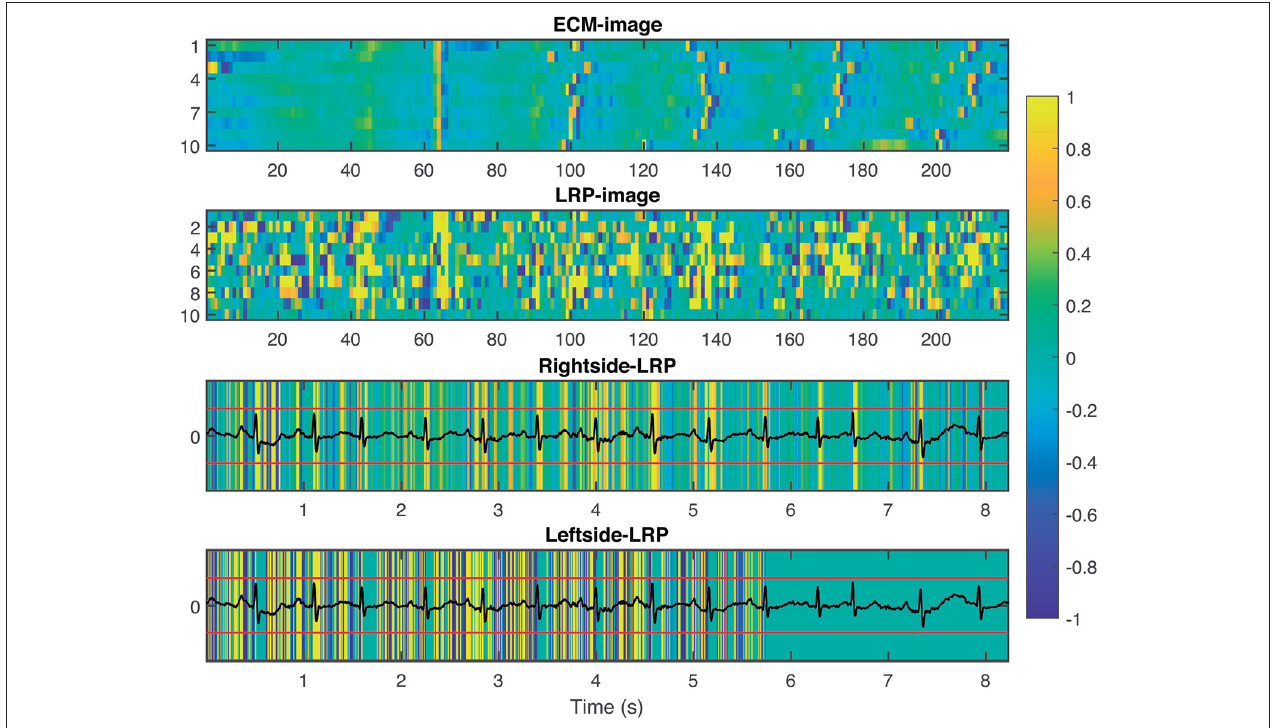
FIGURE 5 | From top to bottom : ECM-image labeled as non-AF and correctly classified as non-AF, heatmap image resulting from the LRP process, rightside-LRP, and leftside-LRP. The rightside-LRP mainly highlights the detection of the QRS complexes while the leftside-LRP captures morphological information used for the